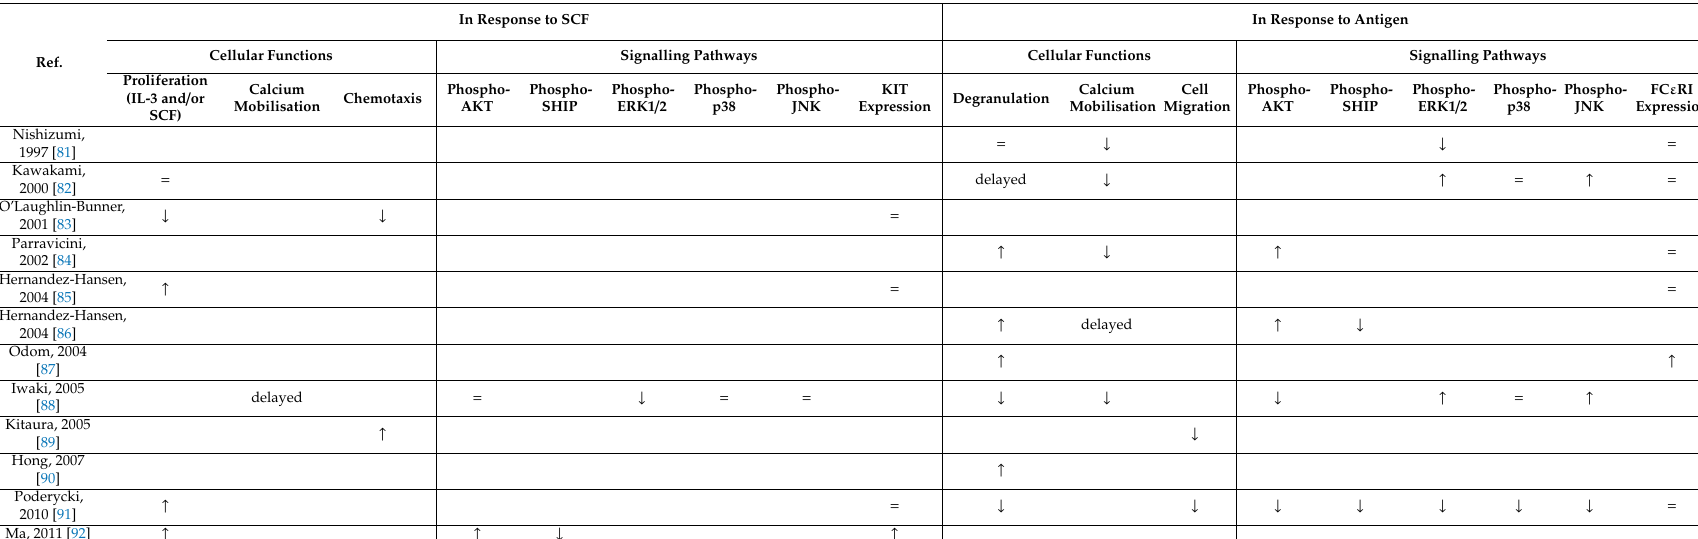
Table 1. Phenotypes observed in lyn − / − mouse models compared to BMMC wild-type cells.